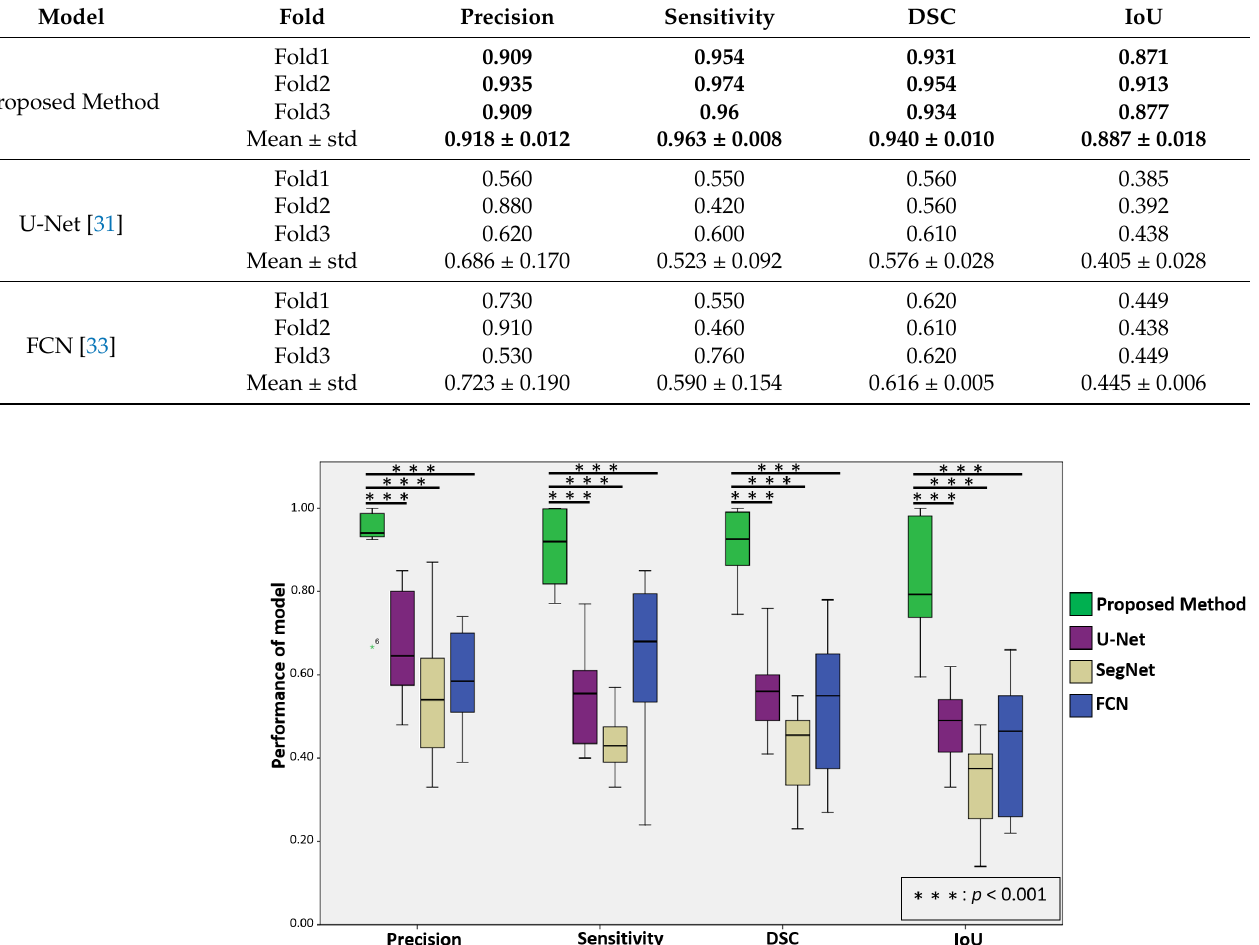
Figure 5. The box plot of quantitative evaluation results of metastatic lesion segmentation where the outliers > 3 × interquartile range are marked with an asterisk. The LSD test results demonstrates that the proposed method performs significantly better than the baseline methods ( p < 0.001).